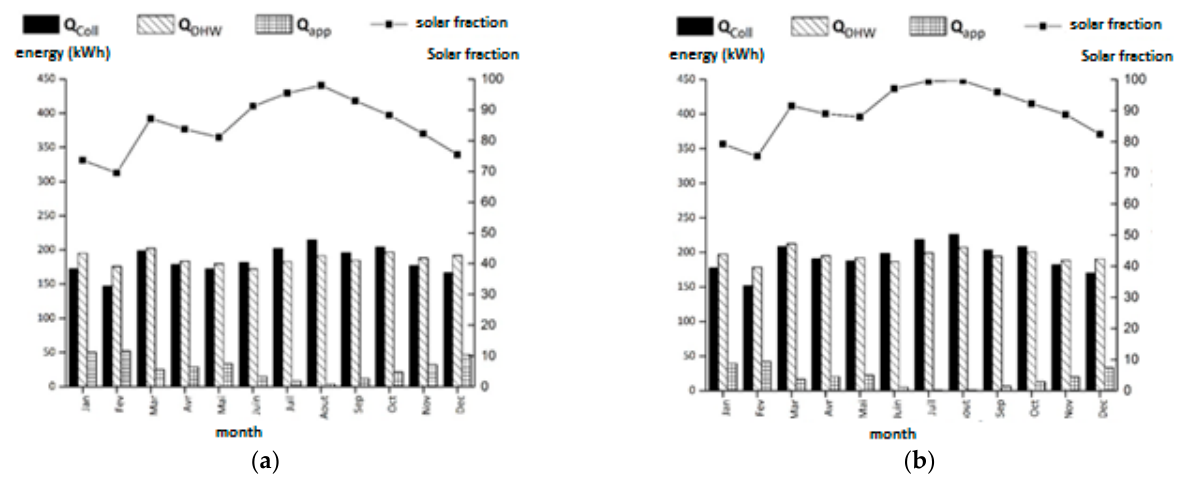
Figure 8. ( a ) Flat plate collector, ( b ) evacuated tube collector (low demand).